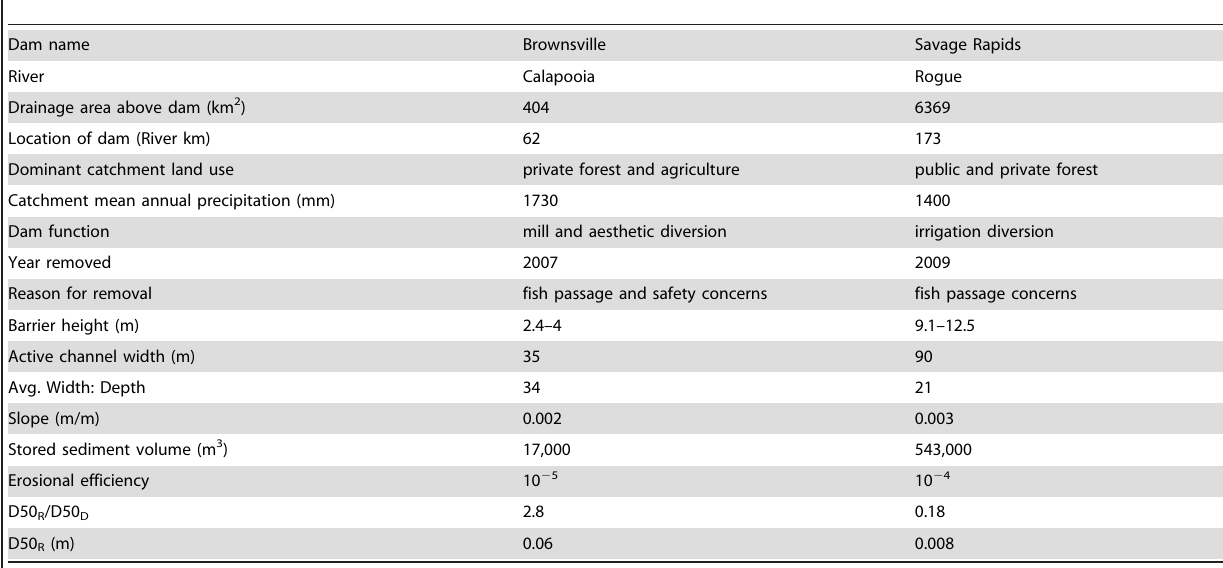
Table 1. Characteristics of the study reaches and sediment reservoirs.